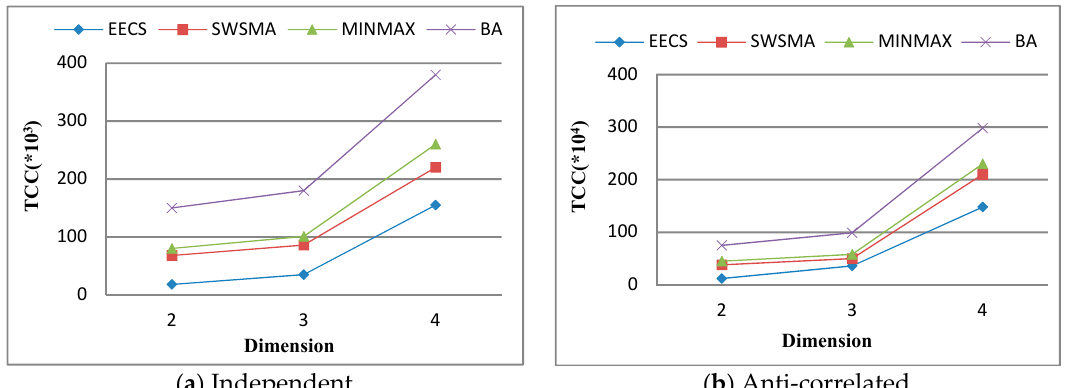
Figure 6. Performance vs. dimension.